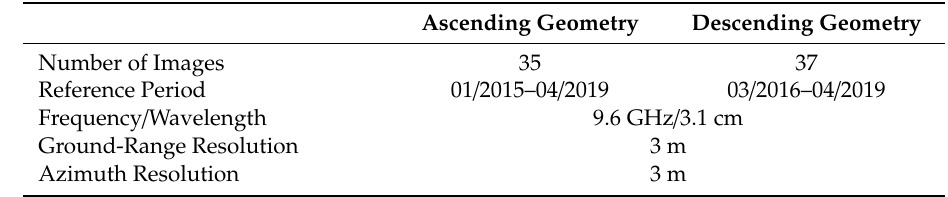
Table 2. Main features of the Synthetic Aperture Radar Interferometry (SAR) imagery dataset from the COSMO–SkyMed mission—Italian Space Agency (ASI).